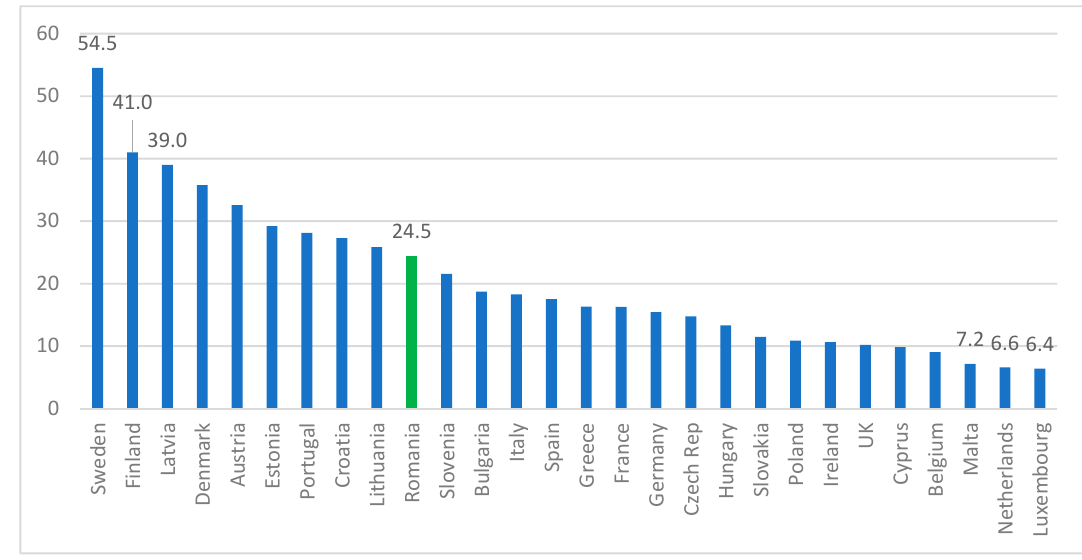
Figure 2. Share (%) of renewable energy in gross final energy consumption in EU Member States, in 2017. Source: EUROSTAT.